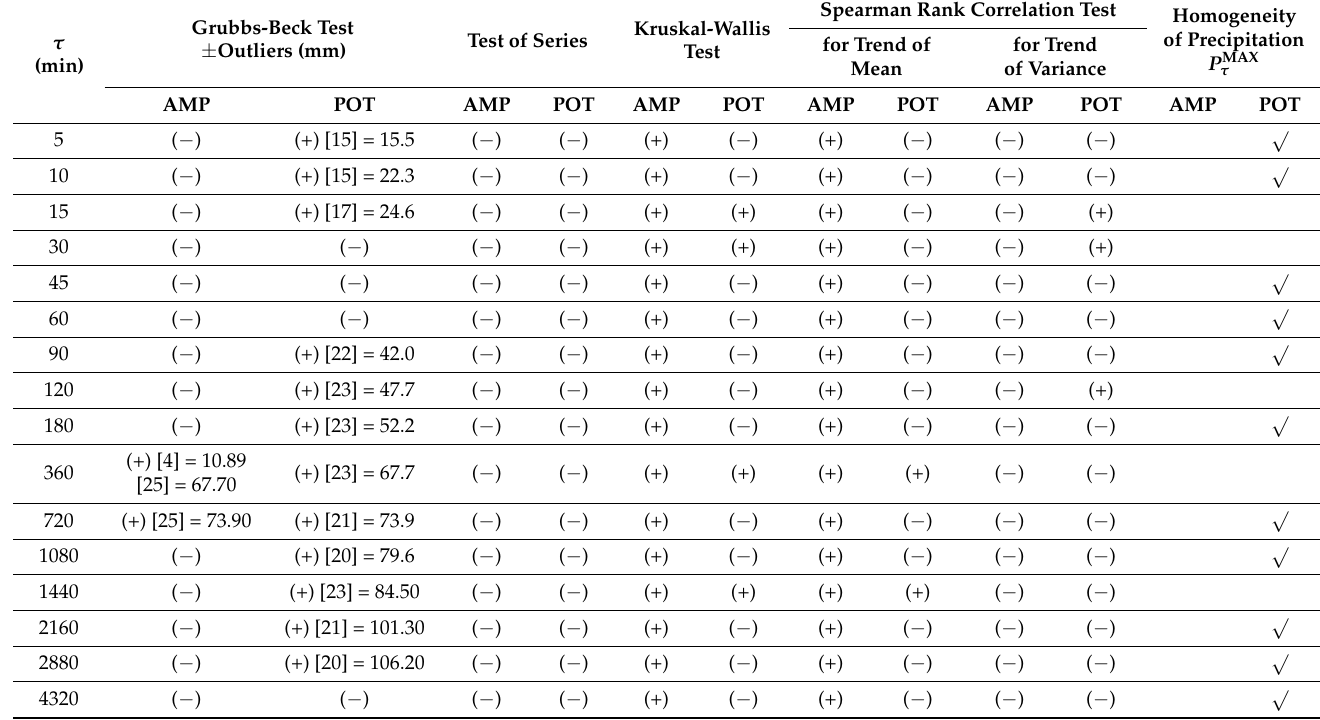
Table 3. Results of nonhomogeneity analysis of AMP and POT precipitation series from Bialystok meteorological station; ( − )/(+) denotes, respectively, negative and positive test results;